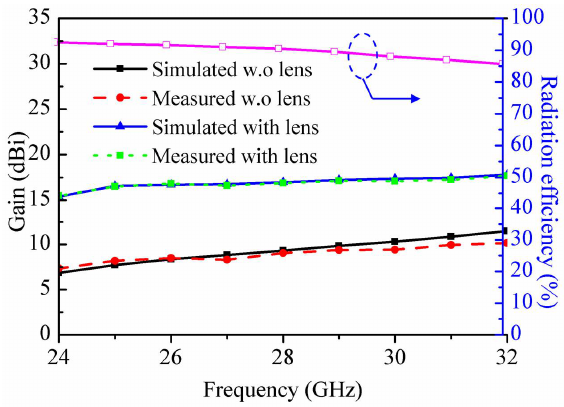
Figure 10. Simulated/measured gain (left axis) of Yagi antenna with/without proposed fractal GRIN lens and radiation efficiency (right axis) of final structure.